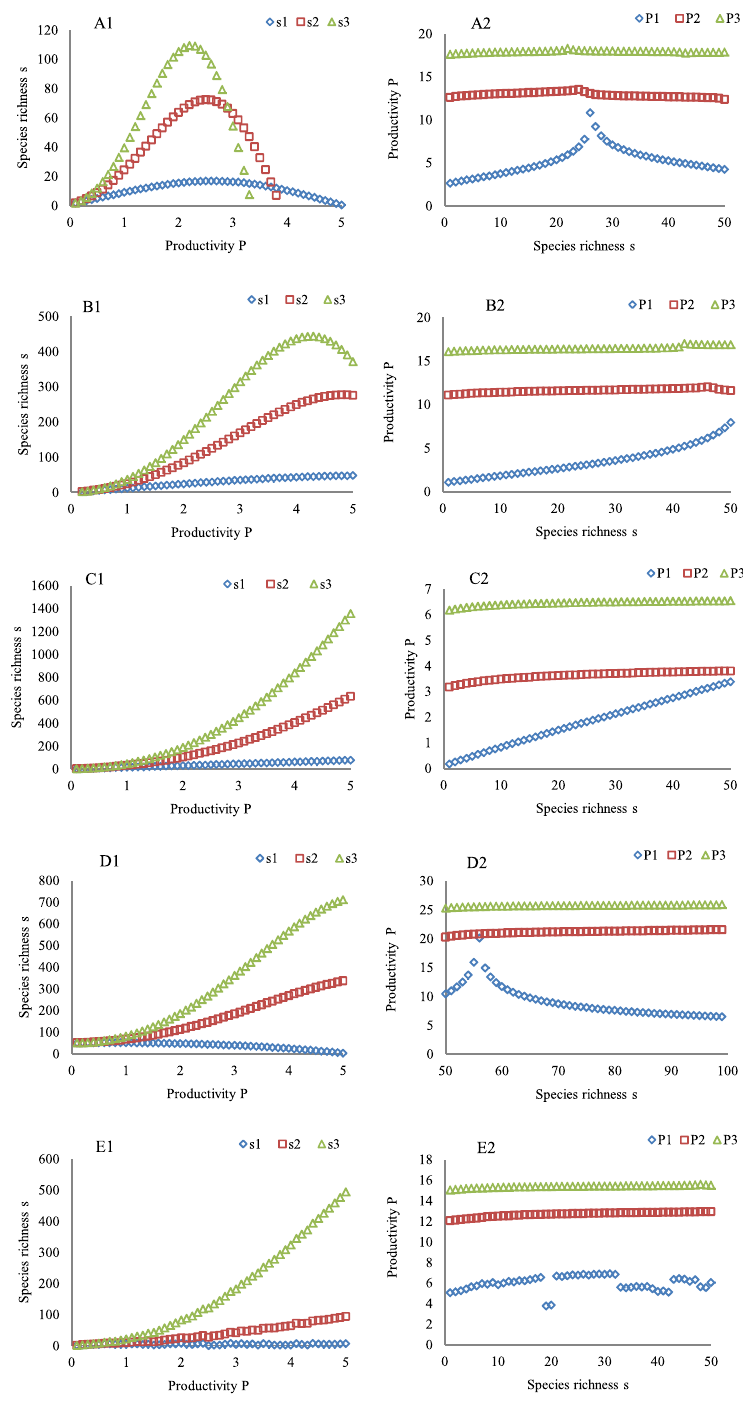
Figure 4. Changes in the forms of the PSRR and SRPR with the intrinsic rate of species richness ( m 1 ), resource availability ( m 2 ), and effect coefficient ( a ) related to the species pool and environmental heterogeneity ( E h ) across different zonal forests. The addition of increments to m 1 , m 2 , a , and E h leads to the formation of gradients in m 1 , m 2 , a , and E h , respectively, starting from DCF across ENF, TDBF, ECBF, EBF, and TRF from the north to south in Russia, Japan and the Philippines 48 . These gradients are created by assigning increments of 0.05, 0.05, 0.02, and 0.06 to m 1 , m 2 , a , and E h , respectively, spanning over one productivity unit on the x-axis for the s 2 curve from ( A1 – E1 ) and 0.1, 0.1, 0.03, and 1 for the s 3 curve. Other parameters that are substituted into Eqs 10, 11, and 21 are equal to the first value in each cell in the data columns marked with # in Supplemental Table 1. P 0 and S 0 in a southern forest are assumed to be greater than those in a northern forest. The s 1 curve is a control, and the values of the parameters used to derive it are the same as those used to derive the five PSRR and SPRP forms in Figs 1A1–E1 and 2A1–E1. ( A1 ) the humped shape in DCF changes into a humped shape with a high s peak (s 2 and s 3 ). ( B1 ) the asymptotic shape is maintained with a high s peak ( s 2 ) and changes into a shape